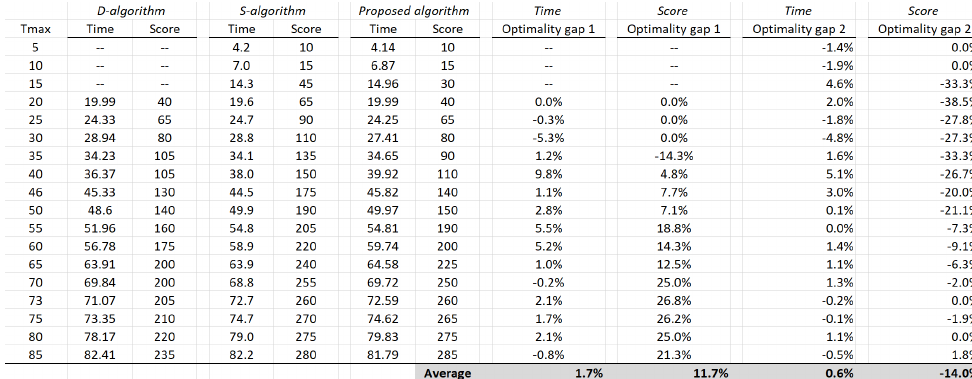
Figure 7. Algorithms comparison using data set of problem 1.